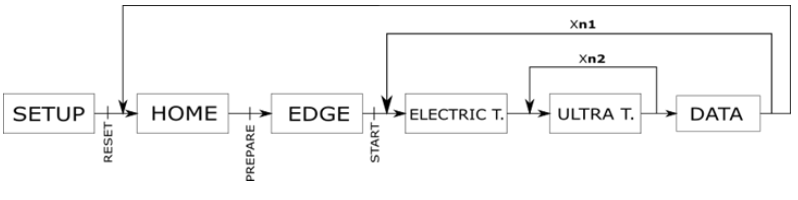
Figure 8. Workflow chart.